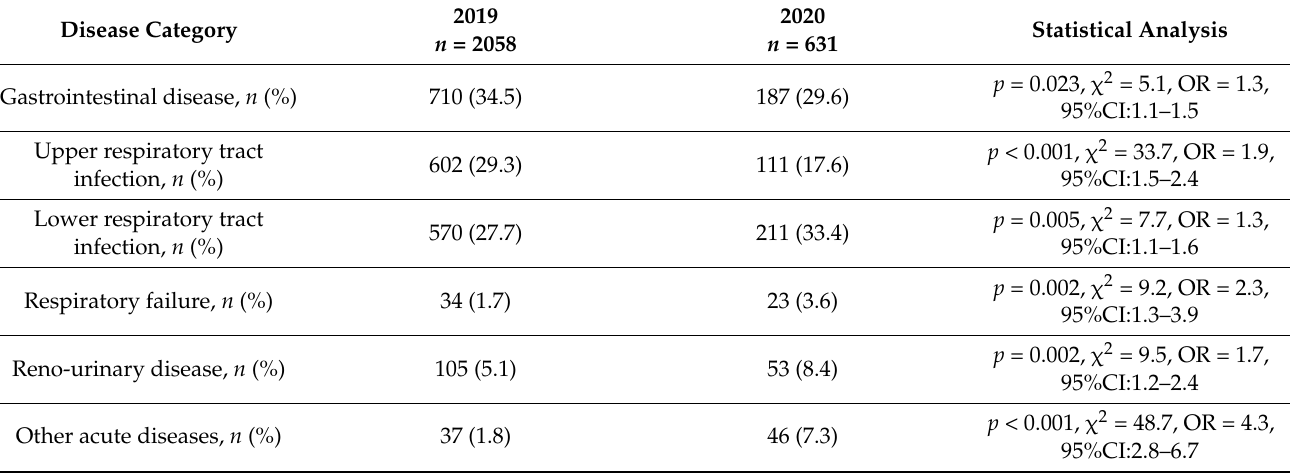
Table 2. Statistical analysis of the proportion of pathologies admitted during the two periods analyzed.